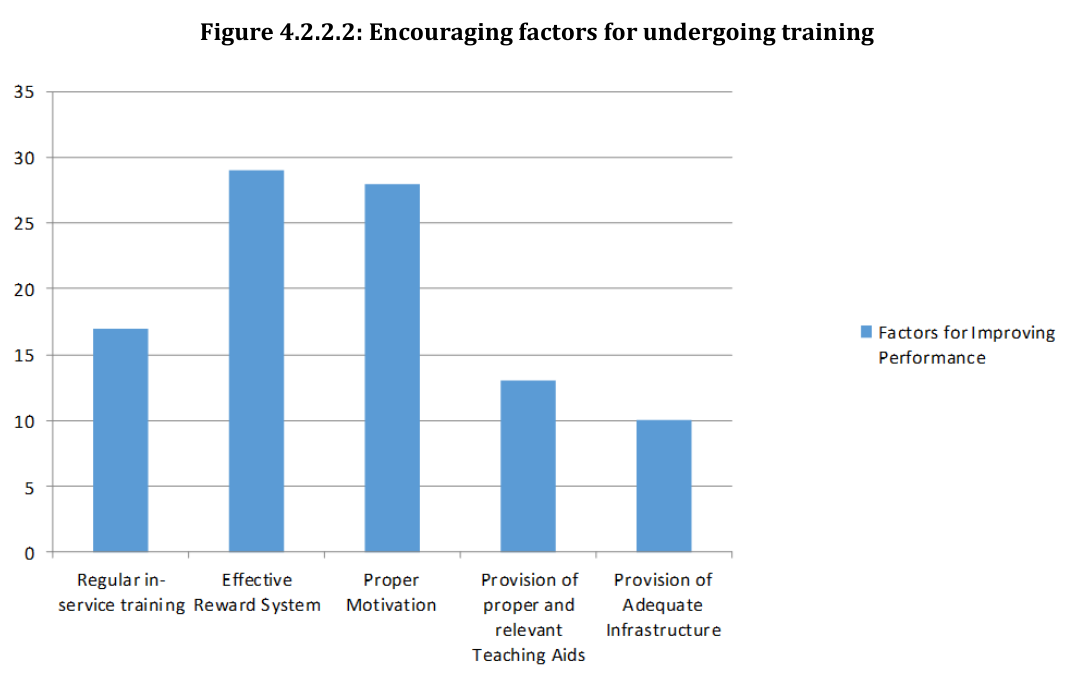
Table 4.2.3: Analysis of variables